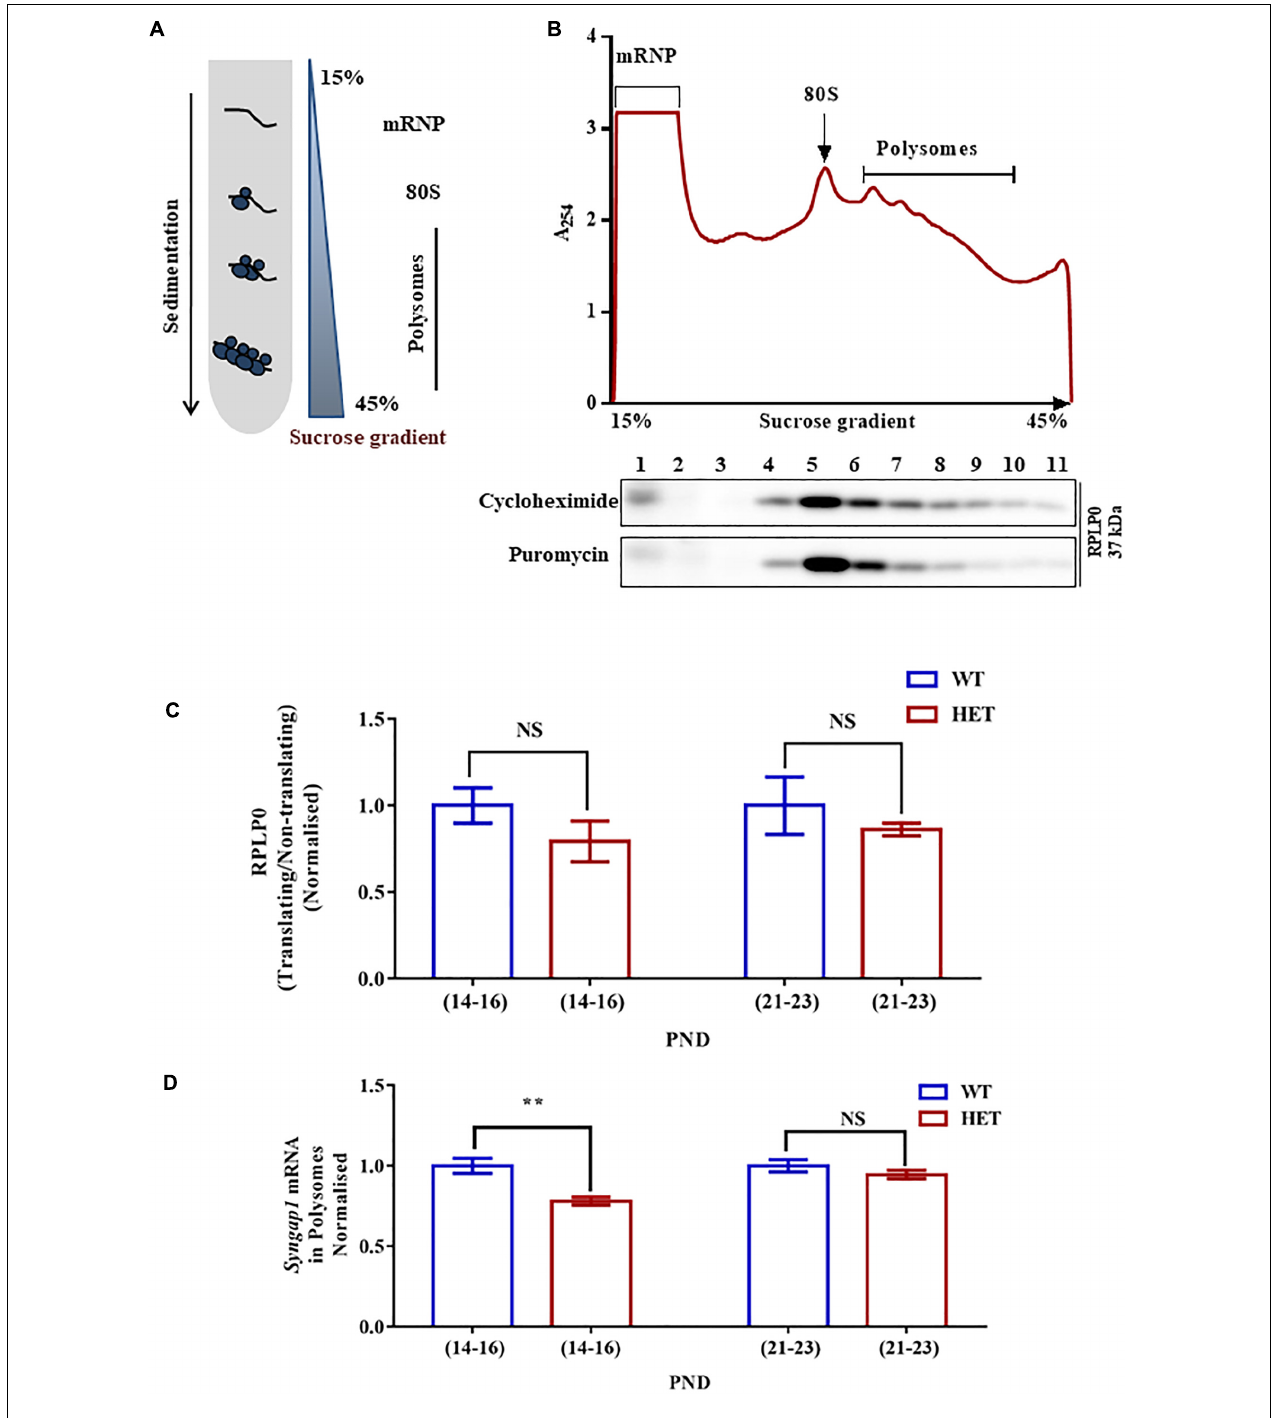
FIGURE 3 | Altered Syngap1 mRNA distribution in translating polysomal fractions of HET. (A) Schematic diagram depicting the sucrose gradient method used for polyribosome profiling (translation assay). (B) Polyribosome profile obtained from Cycloheximide treated hippocampal lysate during PND14-16 in HET ( top ). Representative immunoblots for RPLP0 distribution in Cycloheximide and Puromycin treated polysome during PND14-16 ( below ). (C) Bar graph shows RPLP0 distribution in Translating/Non-translating fractions during PND14-16 (WT: N = 5; HET: N = 3; p = 0.22) and PND21-23 (WT: N = 4; HET: N = 4; p = 0.14). Unpaired Student’s t -test was done for both age groups. NS, not significant. (D) Syngap1 mRNA distribution in polysome in HET normalized to WT during PND14-16 (WT: N = 4; HET: N = 6; p = 0.0018) and PND21-23 (WT: N = 3; HET: N = 3; p = 0.3033); ∗∗ p < 0.01; Unpaired Student’s t -test.